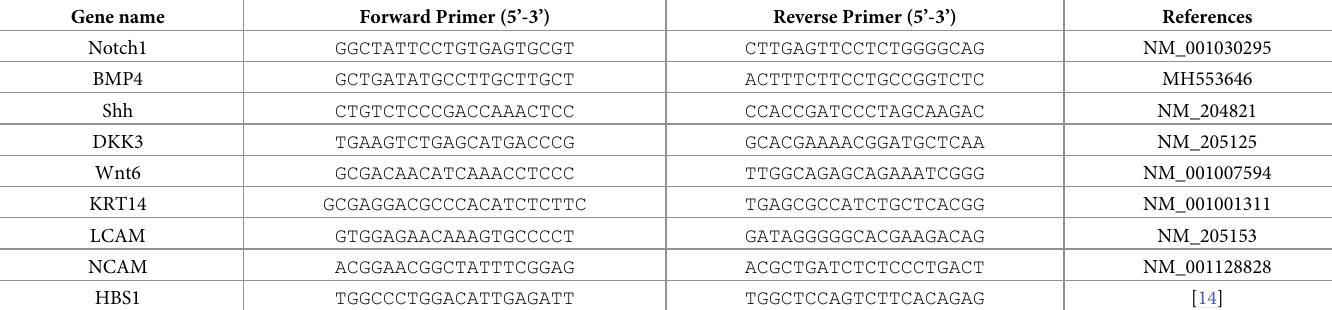
Table 1. Primers used for qPCR in this